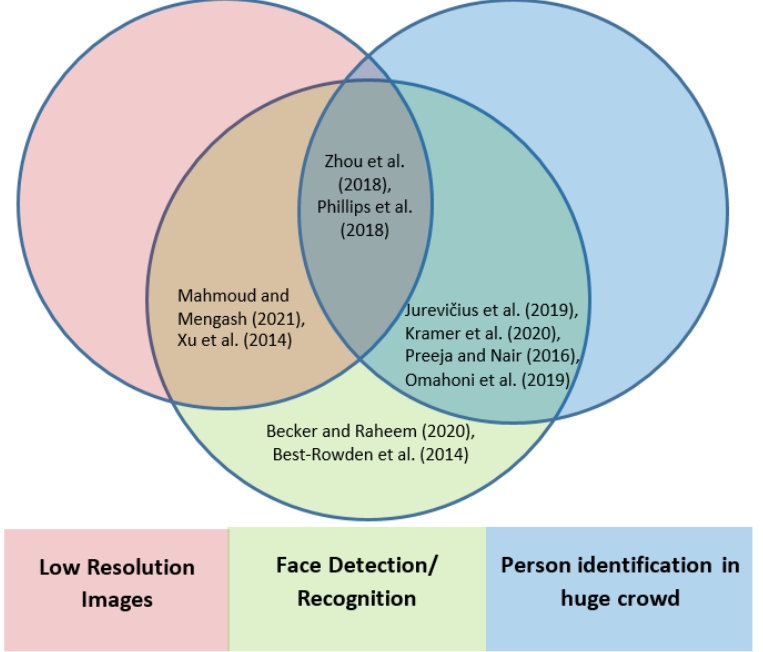
Figure 2. Related work exploration in identifying missing persons in a huge crowd by face detection with low-resolution images